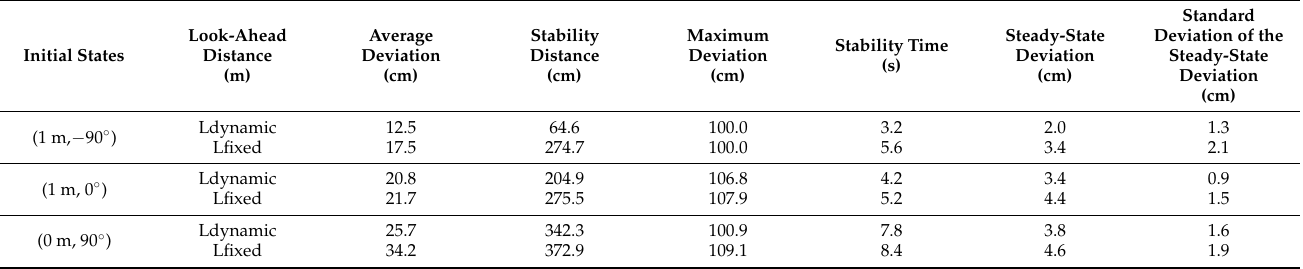
Table 2. Statistics of the linear tracking